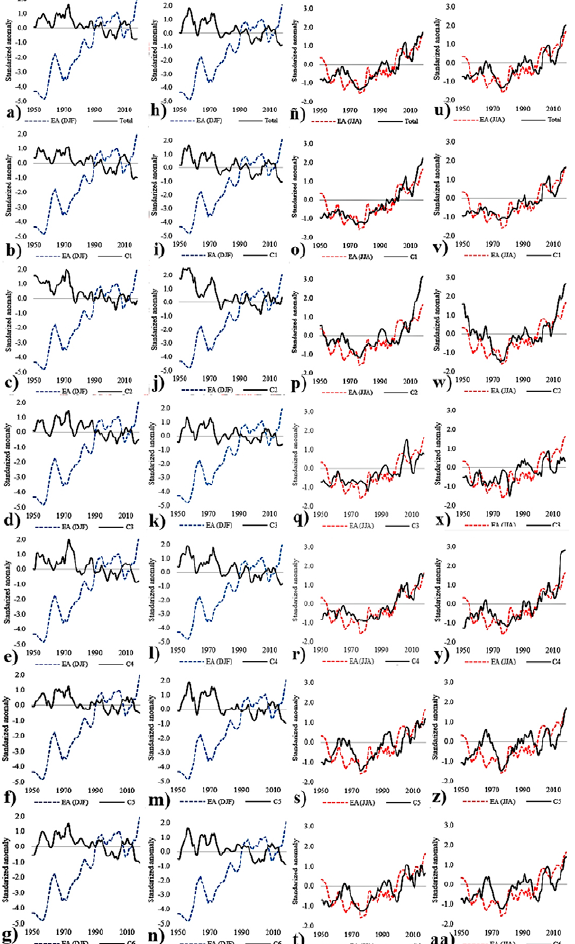
Figure 7. Temporal variability (1950-2018) of the standardized anomalies of the EAi (DJF/JJA) and a-g)